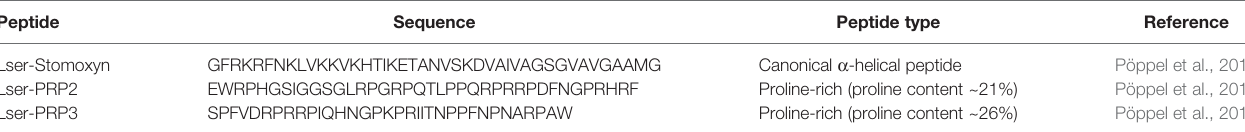
TABLE 1 | Lucilia sericata antimicrobial peptides (AMPs) used in this